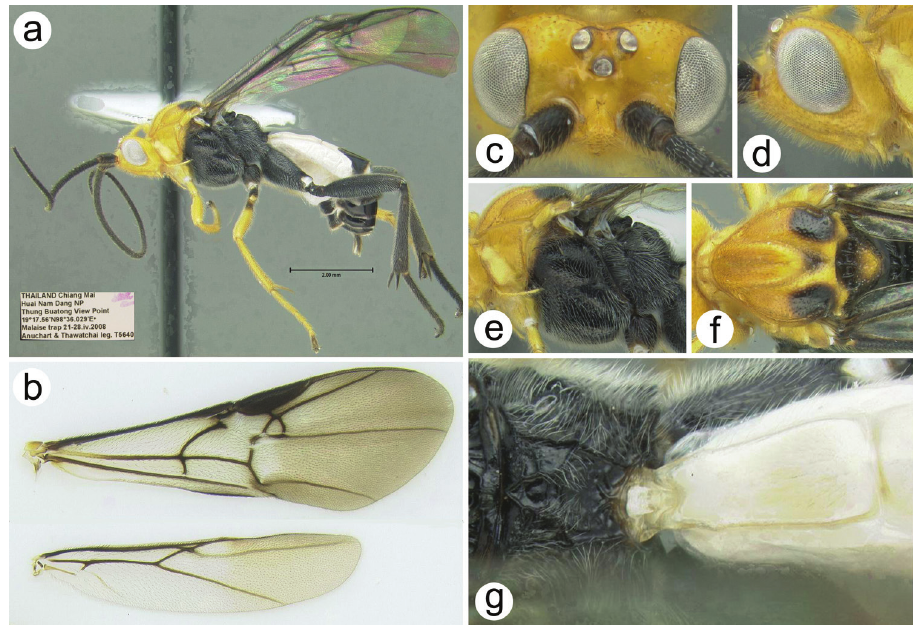
Figure 6. Zelodia chongkraii sp.n. a lateral habitus b wings c dorsal head d lateral head e lateral meso- soma f dorsal mesosoma g dorsal propodeum and